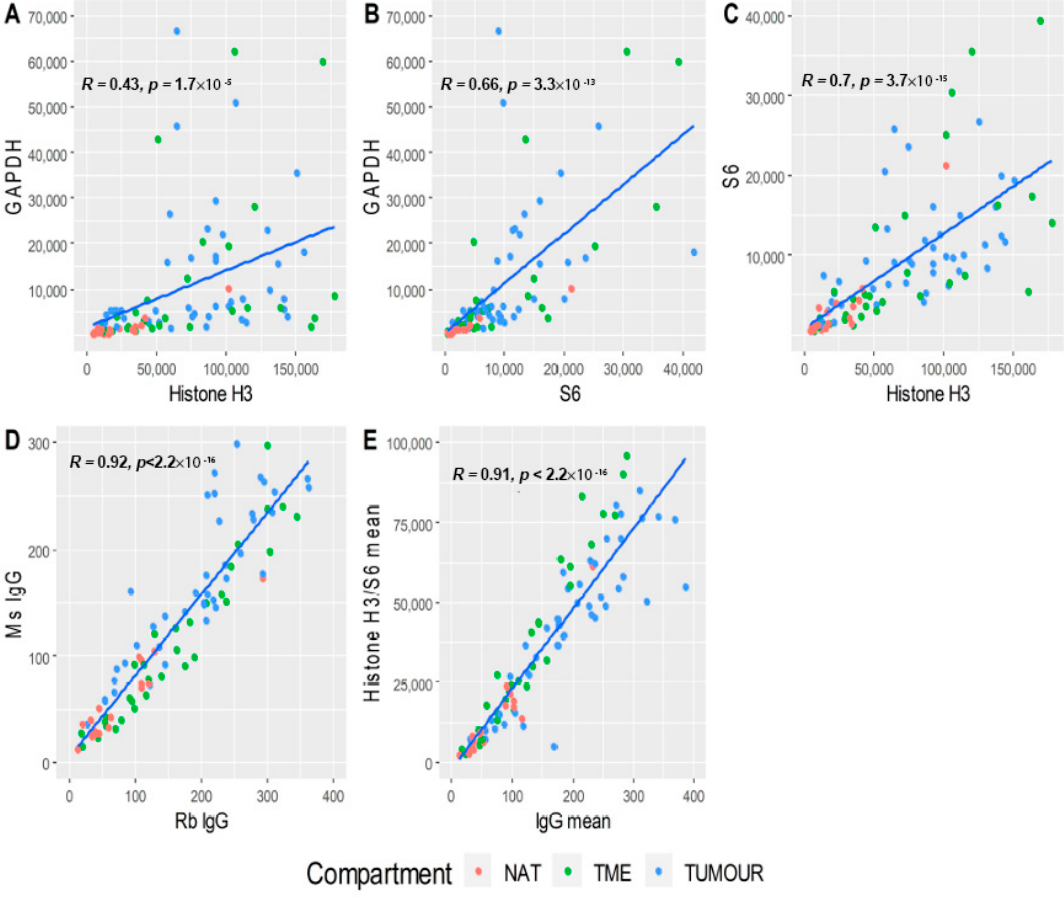
Figure 4. Assessment of housekeeping proteins and IgG as normalisers. Raw counts ( A – D ) and the the means ( E ) of GAPDH, histone H3, S6, and Ms / Rb IgG were compared pairwise and linear means ( E ) of GAPDH, histone H3, S6, and Ms/Rb IgG were compared pairwise and linear regression regressionperformedtodeterminethePearsoncorrelationcoe ffi cient( R )betweenputativehousekeepers. performed to determine the Pearson correlation coefficient ( R ) between putative housekeepers. ( A ) ( A ) GAPDH vs. histone H3, R = 0.43; ( B ) GAPDH vs. S6, R = 0.66; ( C ) histone H3 vs. S6, R = 0.7; GAPDH vs histone H3, R = 0.43; ( B ) GAPDH vs S6, R = 0.66; ( C ) histone H3 vs S6, R = 0.7; ( D ) Ms IgG ( D ) Ms IgG vs. Rb IgG, R = 0.92; ( E ) mean of Ms / Rb IgG vs. mean of histone H3 / S6, R = 0.91. NAT: vs Rb IgG, R = 0.92; ( E ) mean of Ms/Rb IgG vs mean of histone H3/S6, R = 0.91. NAT: normal adjacent normal adjacent tissue; TME: tumour microenvironment; tumour: tumour tissue; TME: tumour microenvironment; tumour: tumour region.